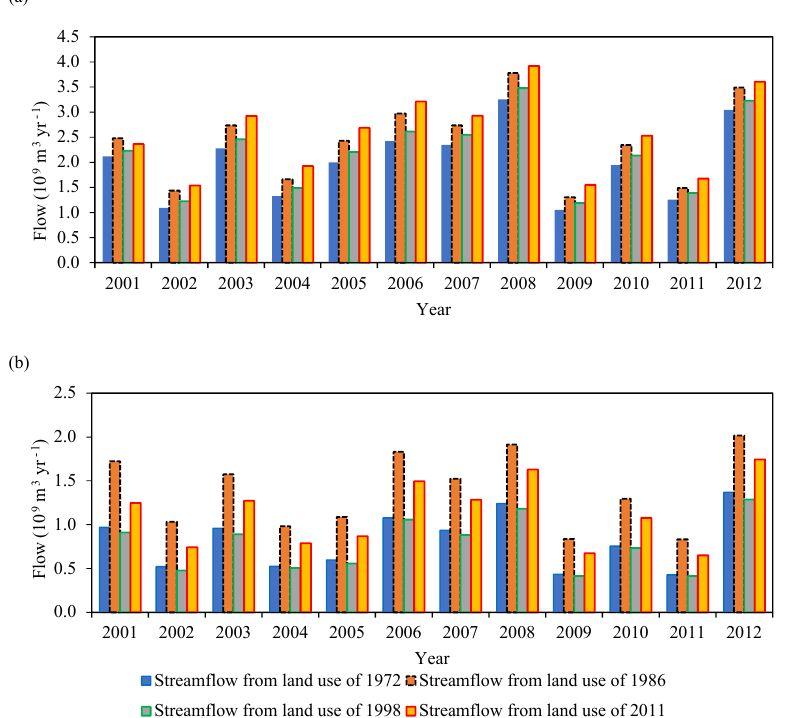
Figure 9. Annual streamflow results from the WFlow model at (a) Al Gewisi station on the Dinder River and (b) Al Hawata station on the Rahad River based on land use from 1972, 1986, 1998 and